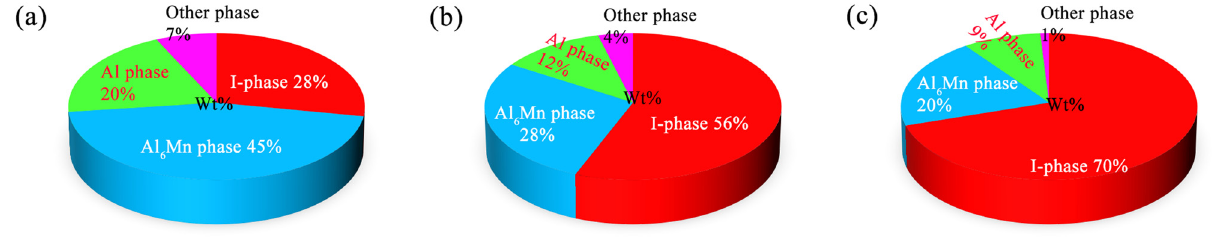
Figure 13: Weight percentage of each phase under three processes ( a ) traditional casting, ( b ) injection casting and ( c )